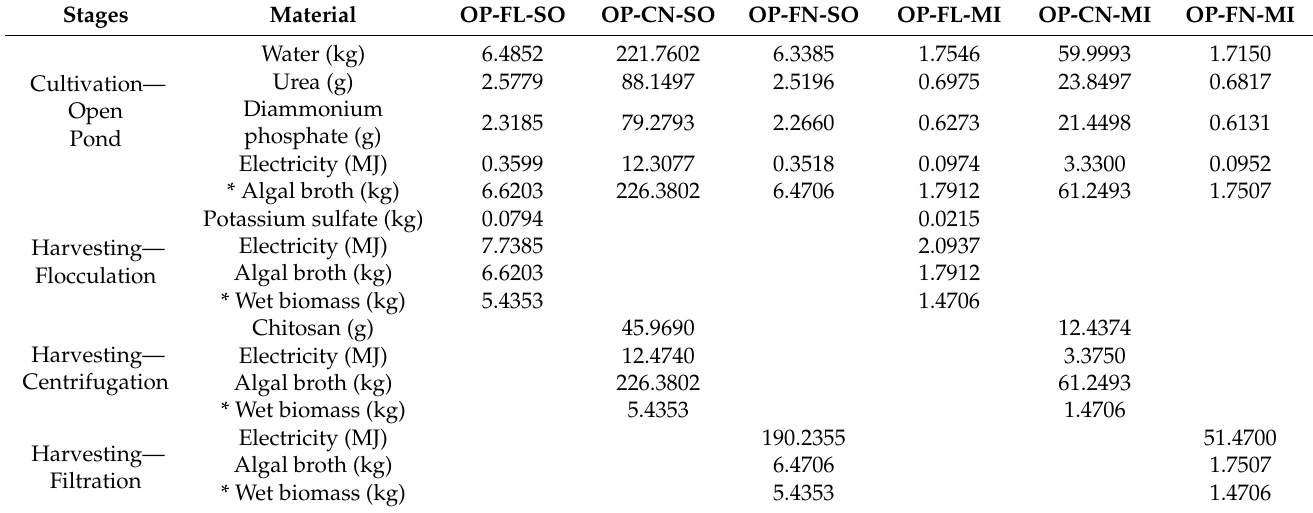
Table A4. Life cycle inventory for 1 kg of biodiesel (open pond systems)